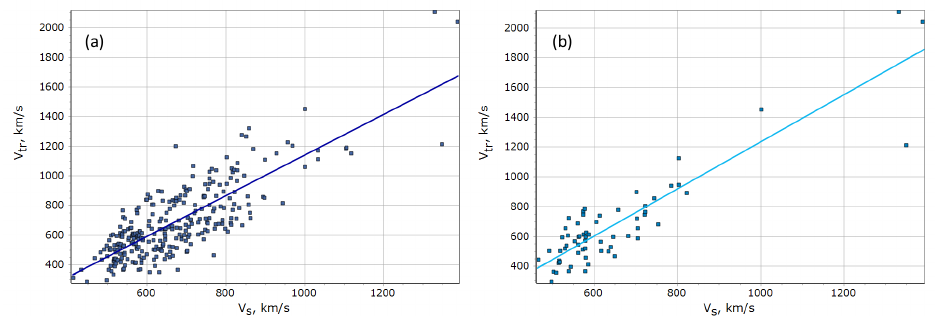
Figure 8. The relationship between actually observed and model-calculated ICME transit velocities for ( a ) the full sample; for ( b ) central events φ < 10 ◦